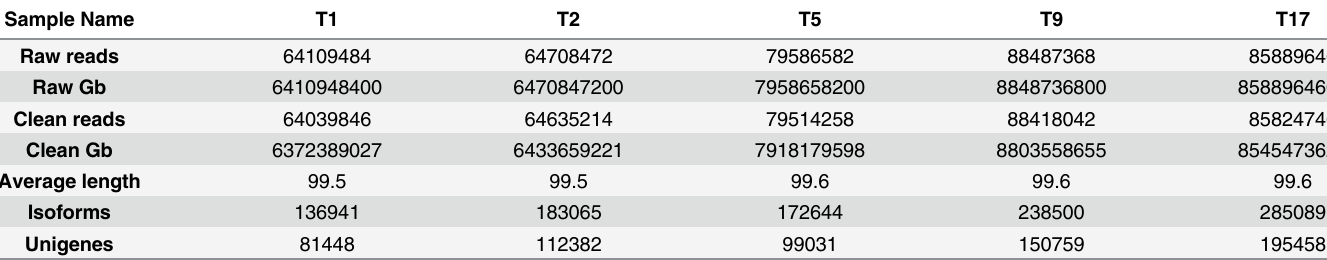
Table 2. Statistical results of raw and preprocessed